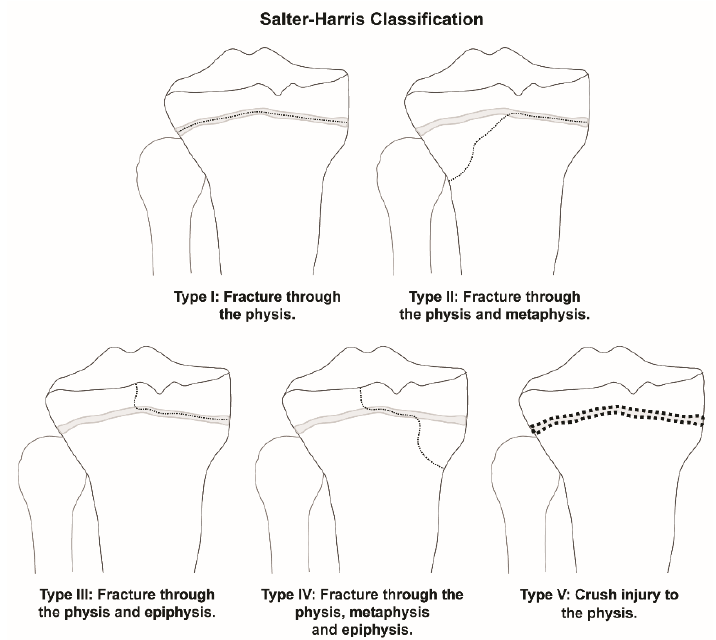
Figure 1. Salter–Harris Classification of pediatric physeal fractures. The five fracture types are shown with the fracture line represented by a dotted line.